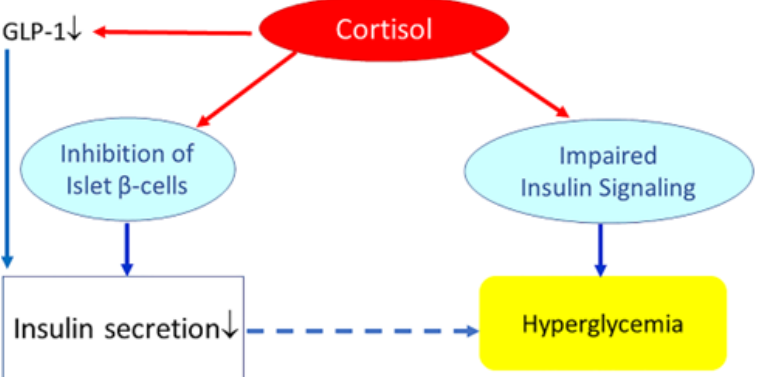
Figure 4. Effects of (high) glucocorticoids on insulin, insulin resistance, and glucose metabolism. Cortisol directly suppresses pancreatic insulin release. It also reduces glucagon-like peptide-1 (GLP-1) production, which further decreases insulin secretion. Increased cortisol also induces